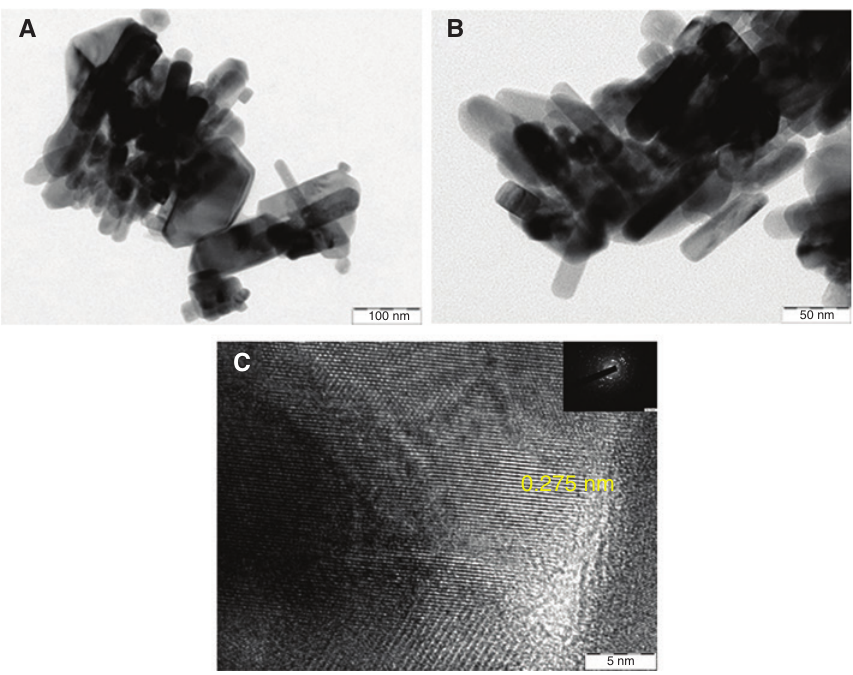
Figure 5: TEM (A and B) and HRTEM (C) images with SAED pattern [inset of image